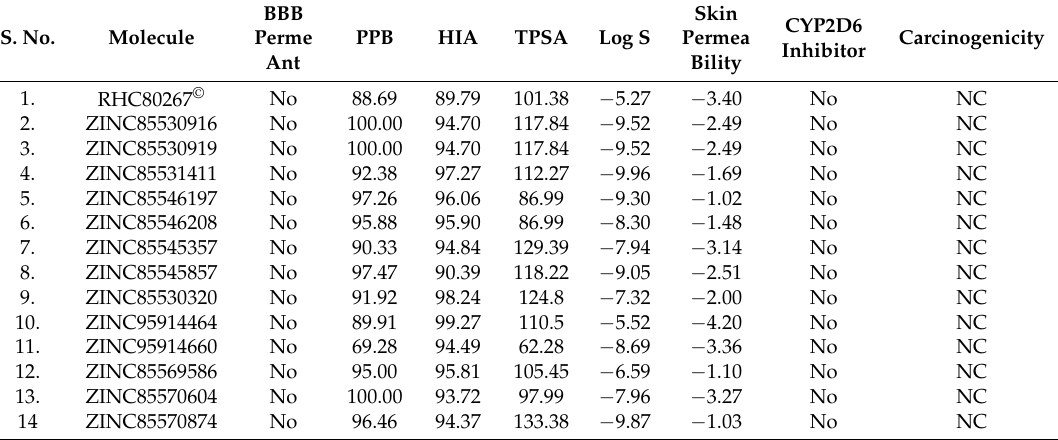
Table 2. ADMET properties of the selected compounds